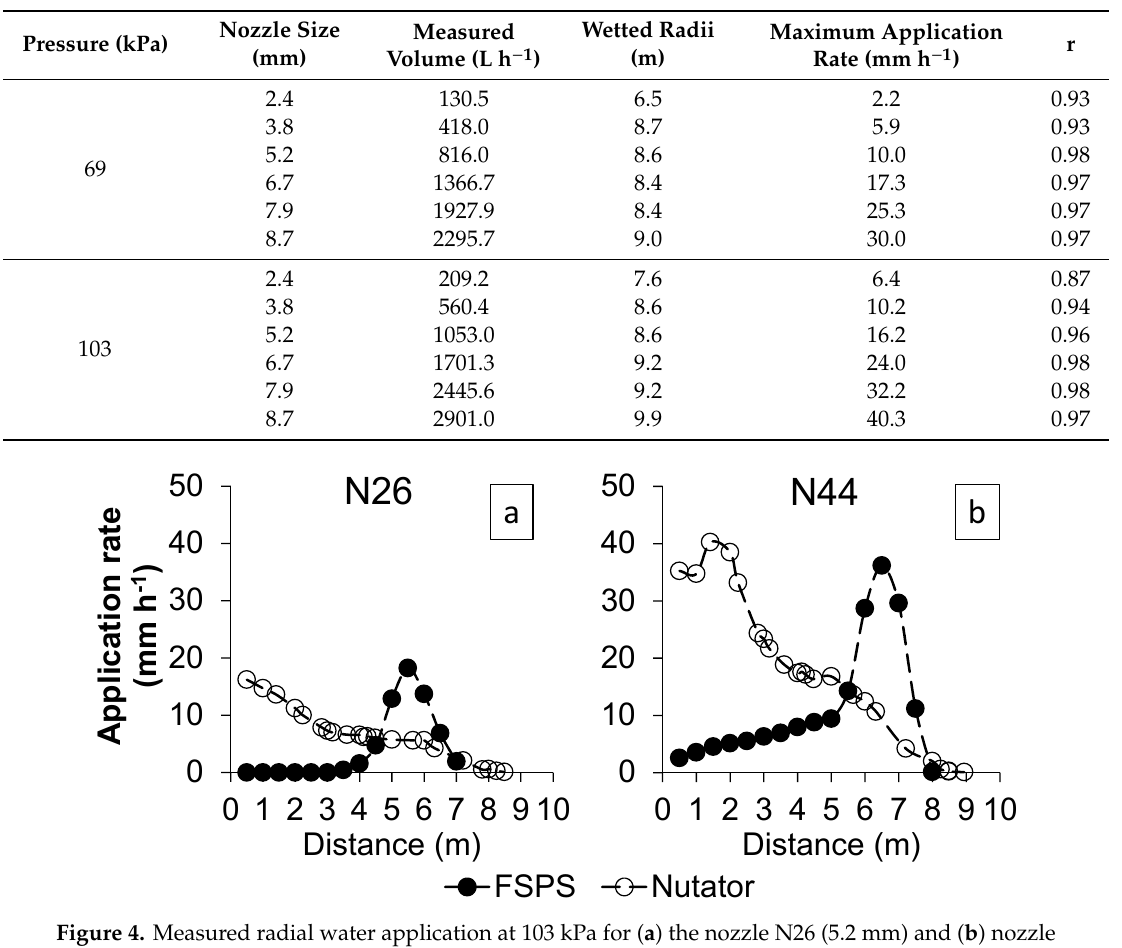
Table 2. Experimental features of isolated sprinklers under low wind conditions.